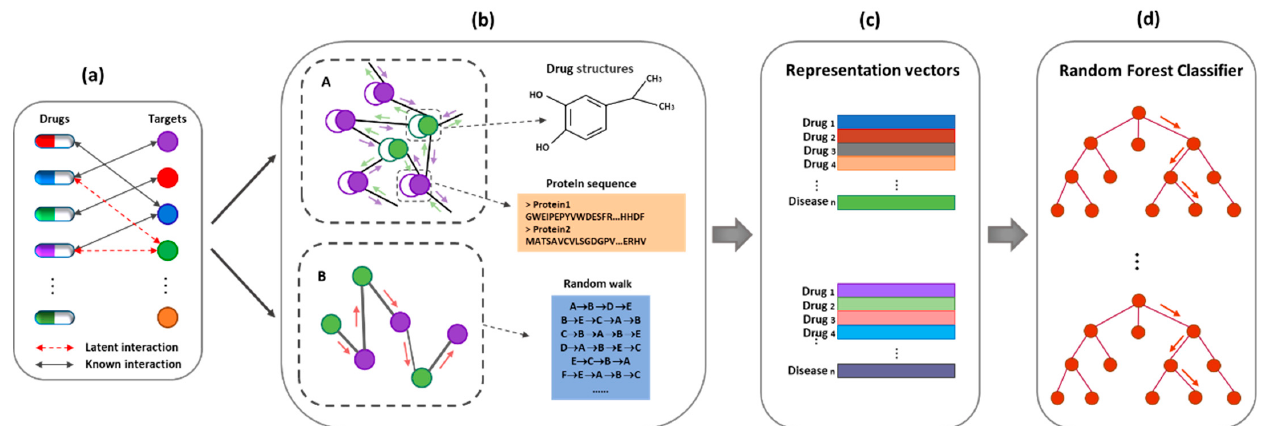
Figure 3. The flowchart of the proposed large-scale graph representation learning DTI (LGDTI). ( a ) A bipartite graph of DTIs. The solid black line is described as known DTIs, and the dashed red line is described as latent DTIs. ( b ) Part A constructed an adjacency graph containing a self-loop, in which green nodes are drugs and purple nodes are targets, and the information of first-order neighbors of each node is aggregated through graph convolutional network. Part B represented high-order information of each node in a bipartite graph by DeepWalk. ( c ) The two kinds of representation features are integrated. ( d ) Random forest classifier is trained and used for predicting new DTIs.